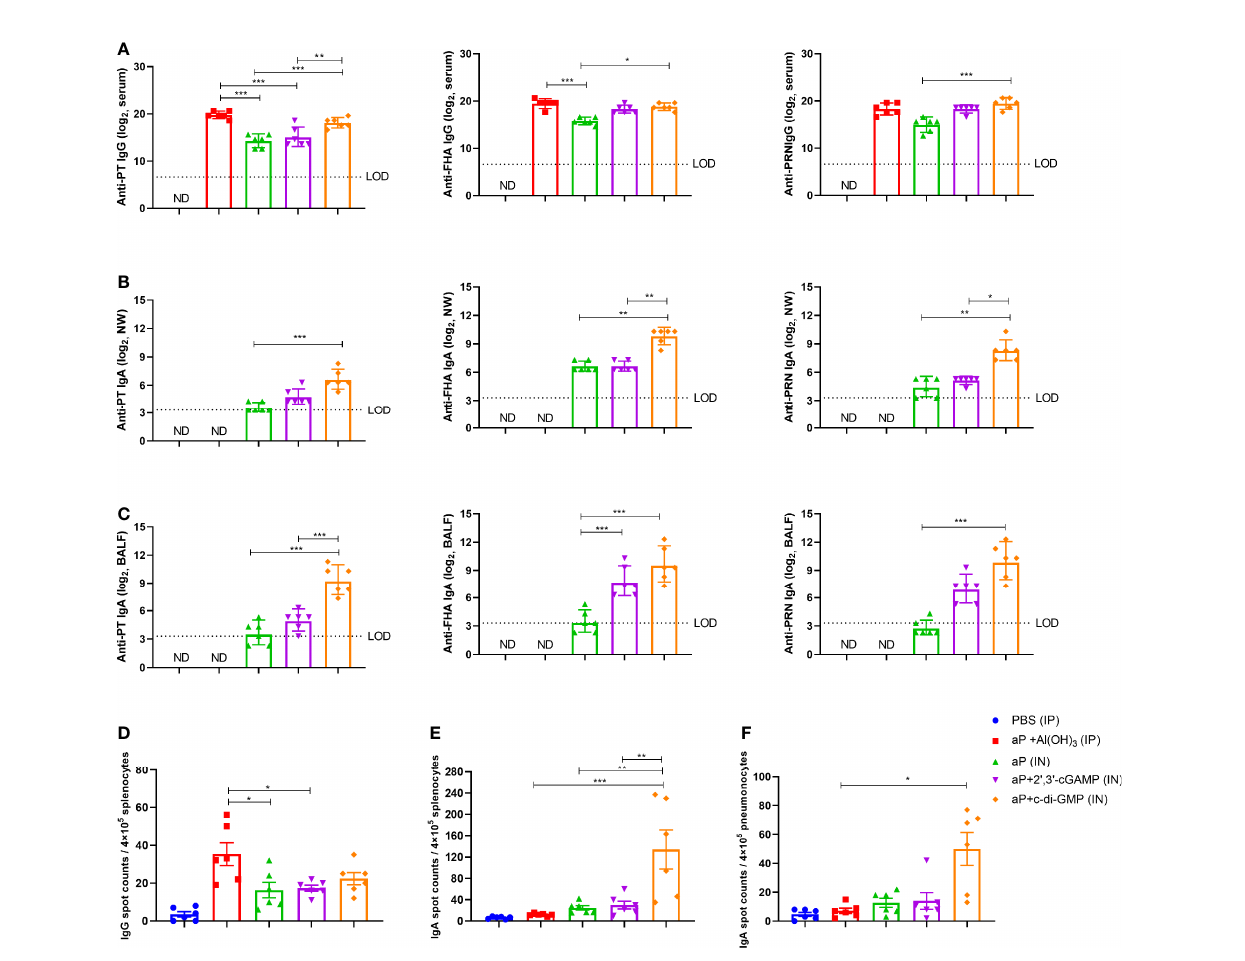
FIGURE 3 | c-di-GMP elicits robust systemic and mucosal humoral responses to the acellular pertussis (aP) vaccine. Mice were intranasally administered the aP vaccine alone or adjuvanted with 2 ’ ,3 ’ -cGAMP or c-di-GMP three times at three-week intervals and euthanized on day 14 after the last immunization. These